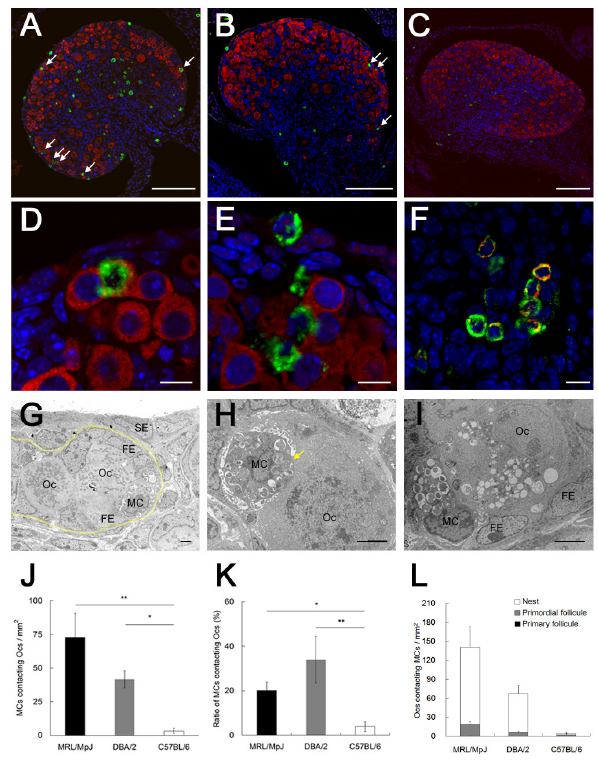
Figure 5. The relationship between mast cells and oocytes in the ovaries of neonatal mice. (A–C) The localization of mast cells (MCs) and oocytes (Ocs) in the ovary at postnatal day 0. Tpsab1 (green) and DDX4 (red) were detected as markers for MCs and Ocs, respectively. In MRL/MpJ (panel A) and DBA/2 (panel B) mice, Tpsab1-positive MCs are detected next to DDX4-positive Ocs (arrows), but only a few Tpsab1- positive signals are observed in C57BL/6 mice (panel C). Bars: 100 µm. (D and E) Higher magnification of the ovaries from MRL/MpJ and DBA/2 mice. In MRL/MpJ (panel D) and DBA/2 mice (panel E), some MCs contact the clusters of Ocs. In addition, some MCs compress the Ocs and show degranulated features. (F) The expression of TNF-α in the ovarian MCs of MRL/MpJ mice at postnatal day 0. TNF-α (red) is expressed in Tpsab1 (green)-positive MCs. Ultrastructure of MCs and Ocs in the ovaries of neonatal MRL/MpJ mice. The nest (surrounded by a yellow dotted line), containing several Ocs and follicular epithelial cells (FEs), is observed beneath the surface epithelial cells (SEs), and MCs are observed in the nest (panel G). Parts of the Oc cytoplasm are compressed by MCs (panel H, arrow), and some Ocs in contact with MCs exhibit vacuolated cytoplasm (panel I). Bars: 2 µm. (J) The total number of MCs contacting Ocs. (K) The ratio of the number of MCs contacting Ocs to the total number of MCs. (L) The number of Ocs contacting MCs. Ocs were categorized according to the developmental stage: nest, primordial follicle, or primary follicle. Data represent the mean ± SEM (n = 4–5 in each group). Significant differences were analyzed using Scheffé’s method subsequent to the Kruskal- Wallis test. *: P < 0.05, **: P <